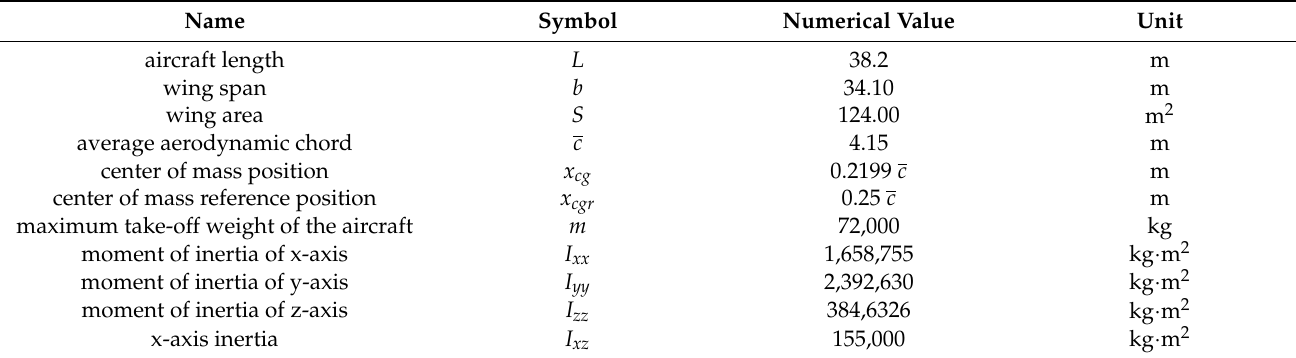
Table 1. Related parameters of background